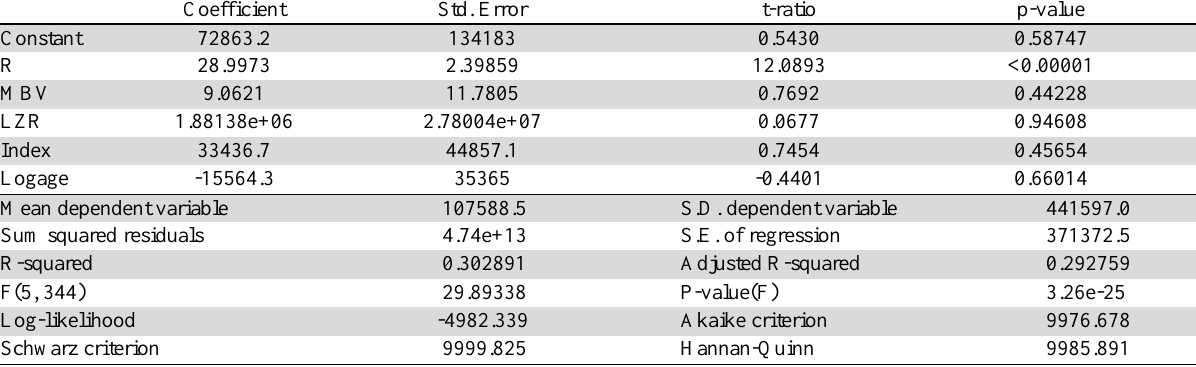
The summary of measuring the effects of different variables on Tobin